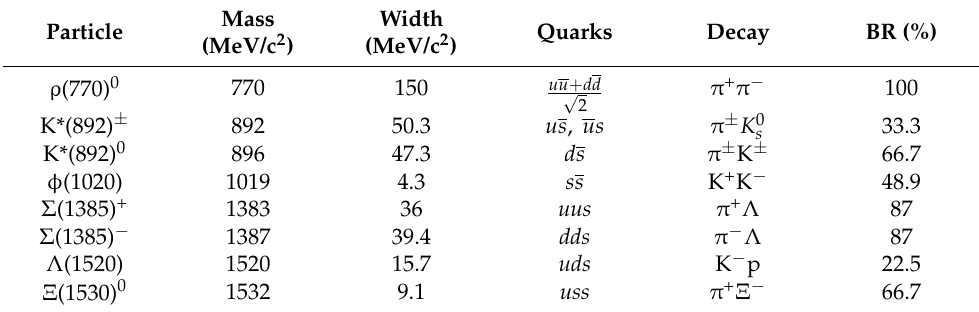
Table 1. Properties of the short-lived hadronic resonances